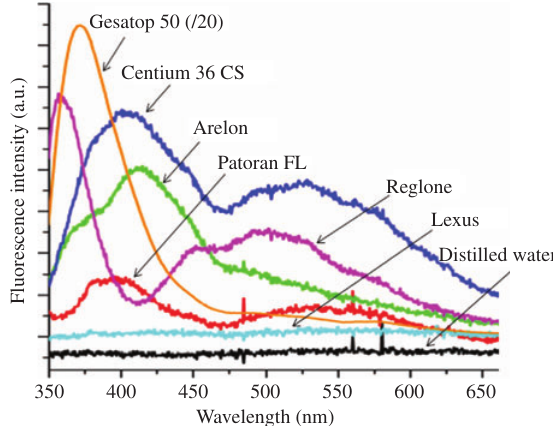
Figure 14 Fluorescence spectra of untreated lemon leaf and lemon leaf contaminated with 1 µ l of Romectin (excitation wavelength: 430